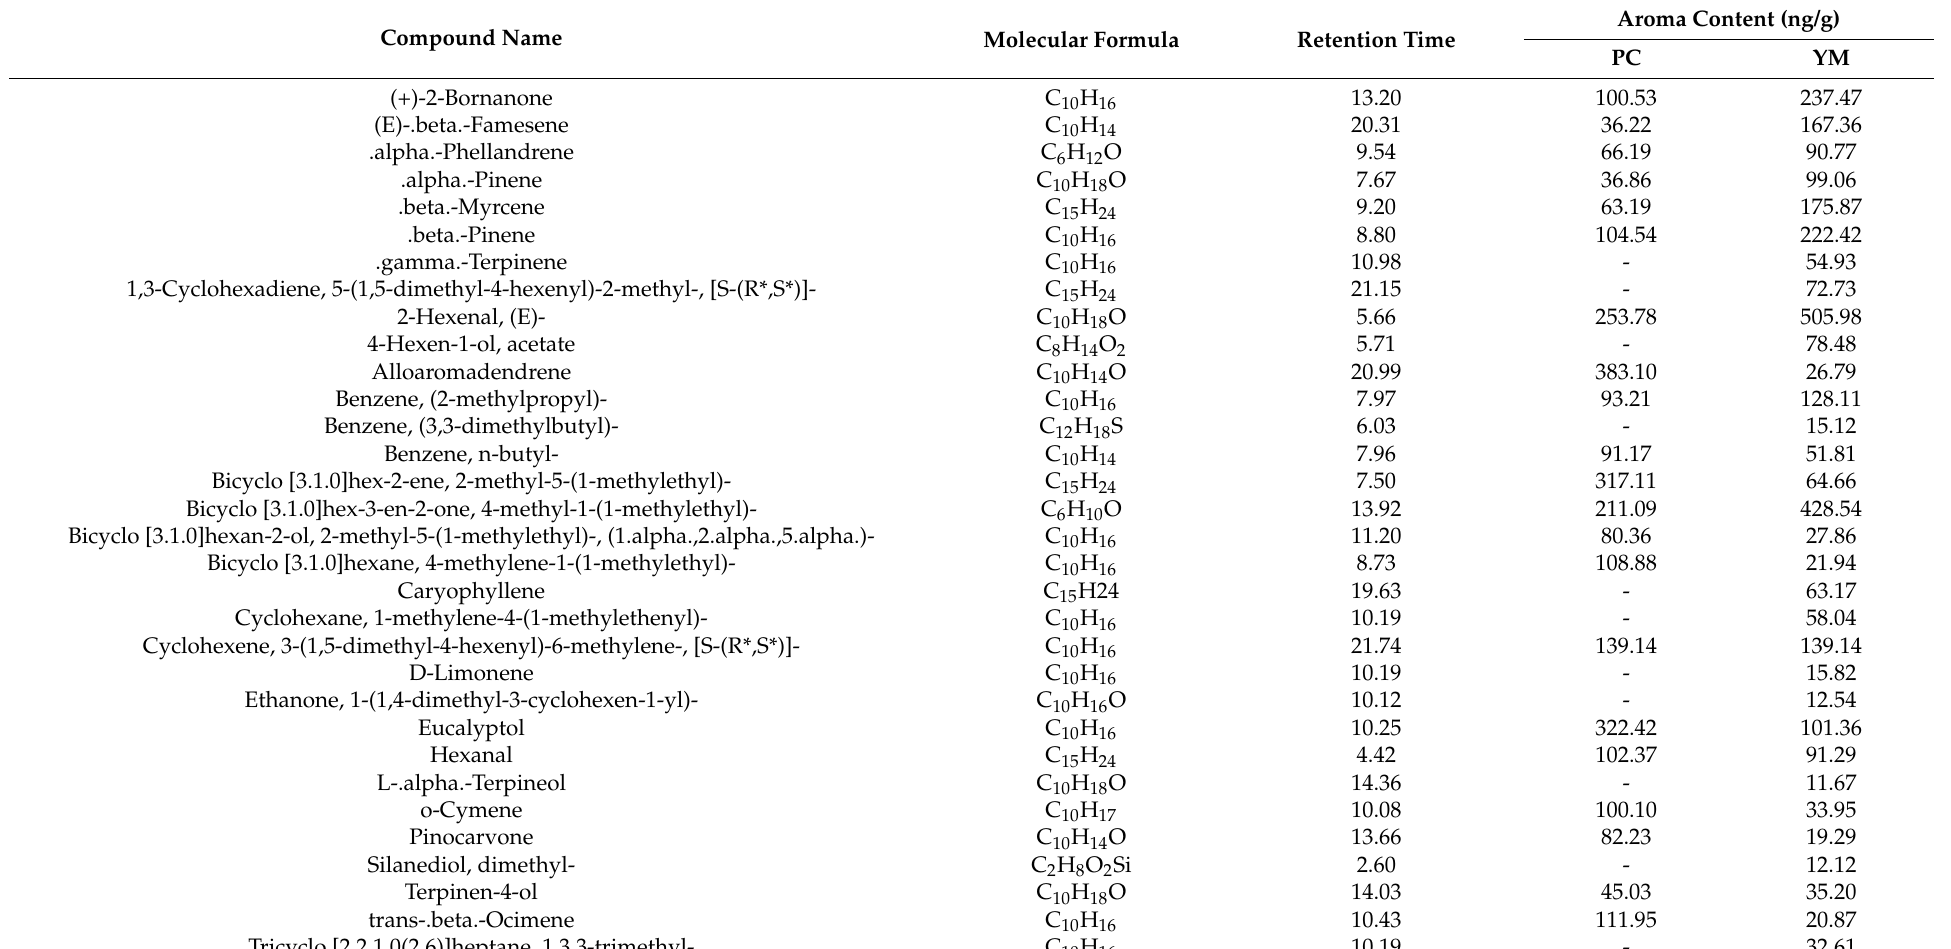
Table 1. The content of flavor compounds in fresh flowers of PC and